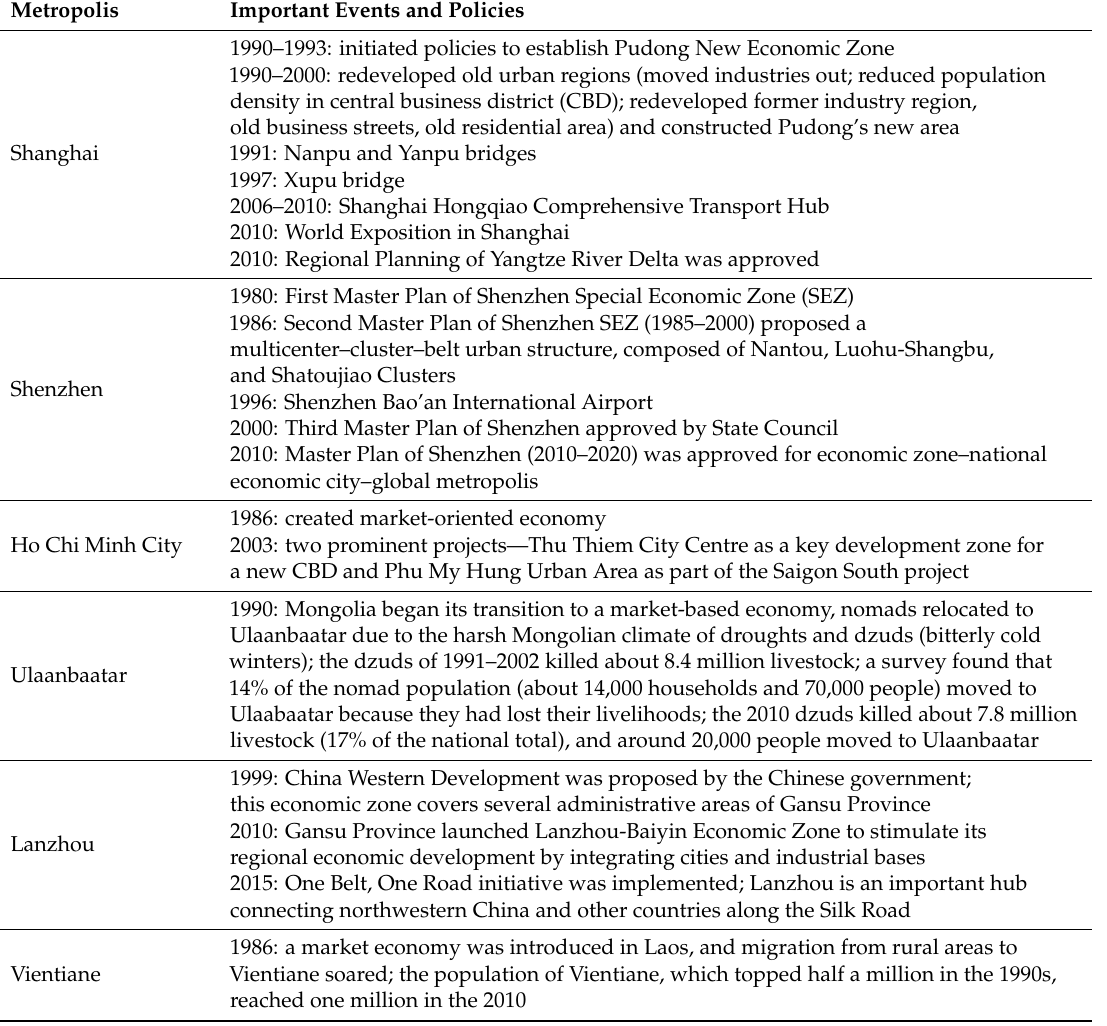
Table 5. Summary of major policies and important events among the six selected